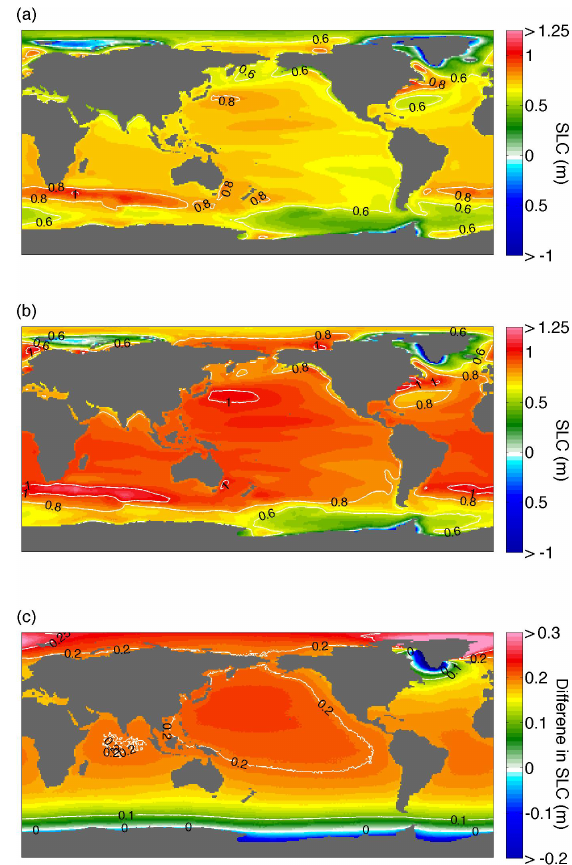
Figure 5. Median sea level rise projections by 2090; regional pro- jections of Slangen et al. (2014) following climate scenario RCP8.5 combined with the contributions to sea level rise due to dynamical ice sheet mass loss: (a) symmetrically distributed ((Church et al., 2013)) and (b) asymmetrically VW15 distributed (De Vries and Van de Wal, 2015). (c) The difference in median ( b − a ). The area- averaged global median depicted in panel (a) is 0.68 and 0.86m in panel (b) . The area-averaged global median difference between panels (b) and (a) is